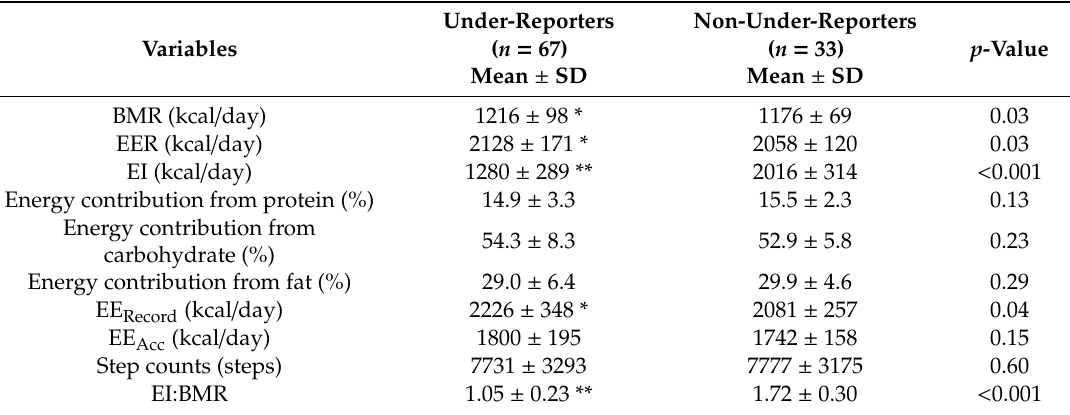
Table 4. Di ff erences in estimated basal metabolic rate, energy intake and energy expenditure between non-under-reporters and suspected under-reporters.